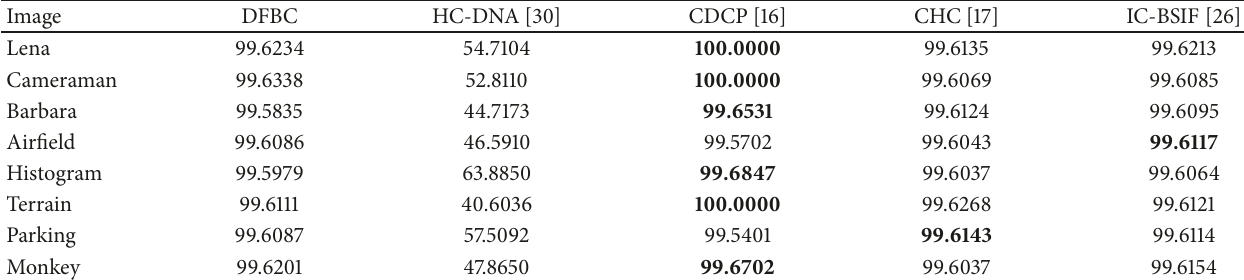
Figure 10: Robustness analysis results of noise and data loss. (a) The encrypted Lena and its decrypted image. (b)-(d) The encrypted Lena with 0.5%, 1%, and 2% salt and pepper noise and its decrypted image, respectively. (e)-(g) The encrypted Lena with 0.4%, 1.56% and 4% data loss and its decrypted image, respectively. Table 4: The average NPCR (%) of running the schemes 10 times.